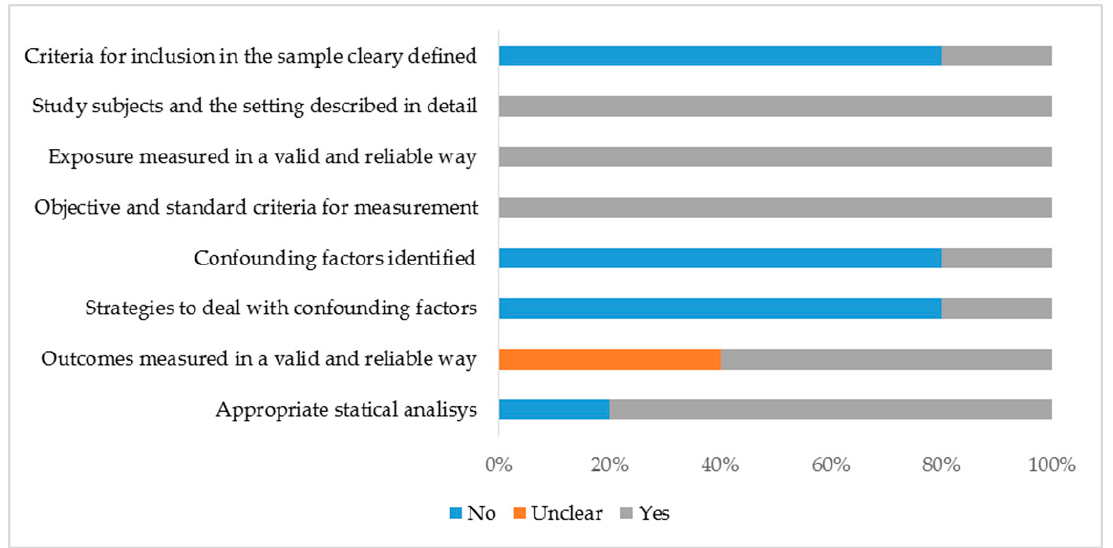
Figure 2. Risk of bias in the included studies (The Joanna Briggs Institute Critical Appraisal Checklist for Analytical Cross-Sectional Studies).